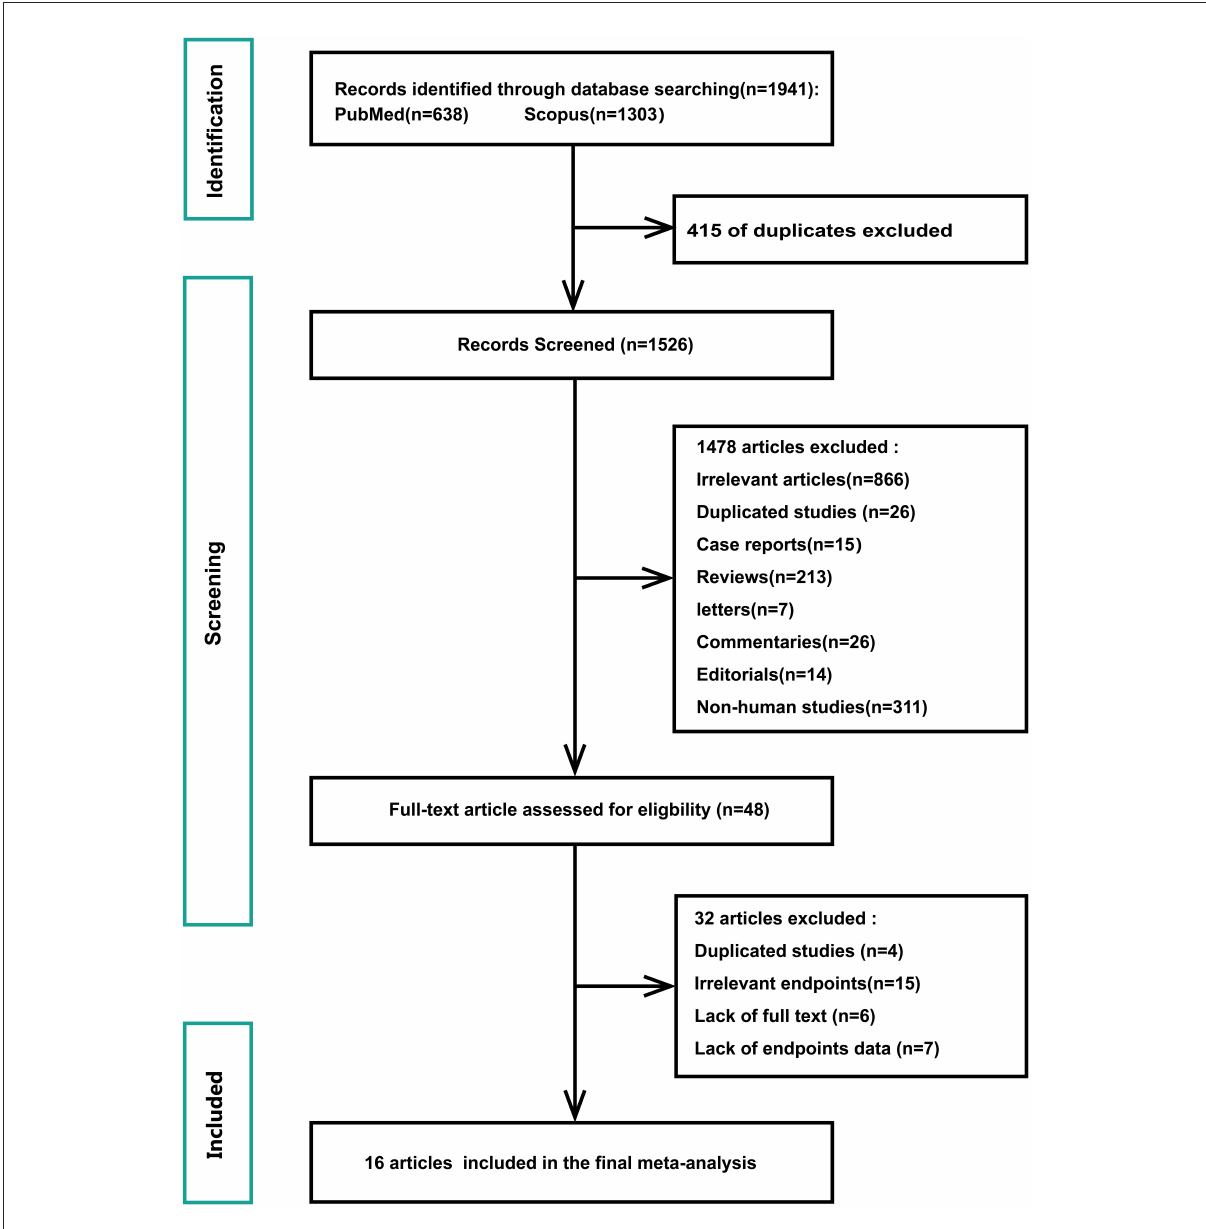
FIGURE1 Flowchart of database search and text screening